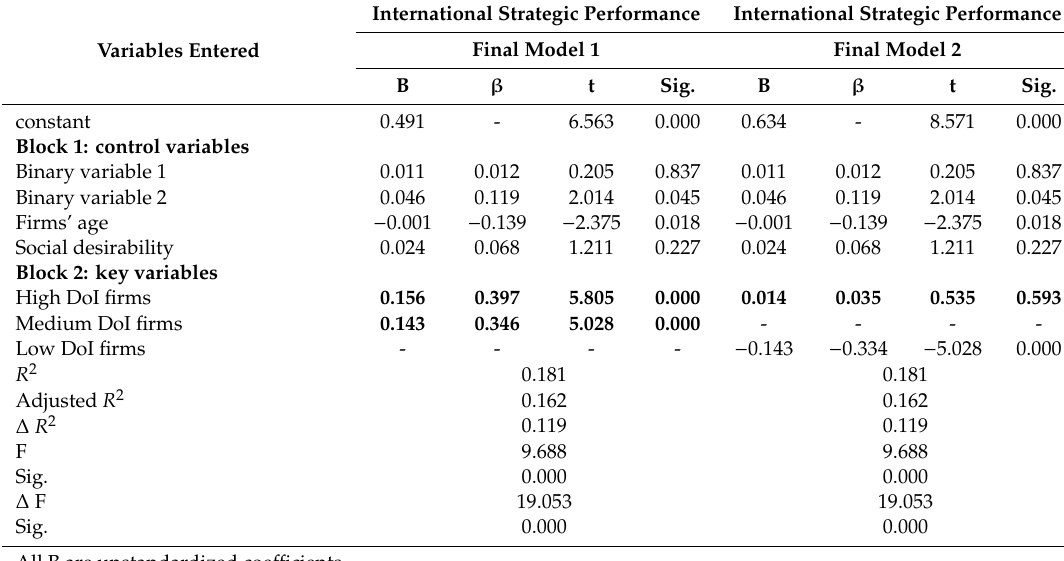
Table 3. Regression analysis (international strategic